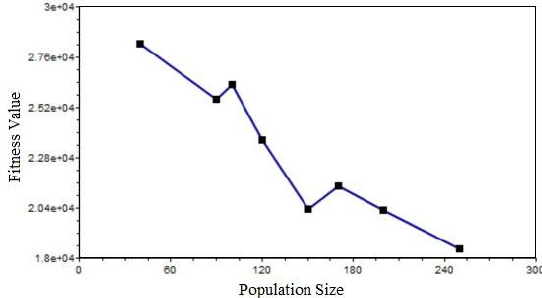
Figure 8. Effect of population size on fitness value